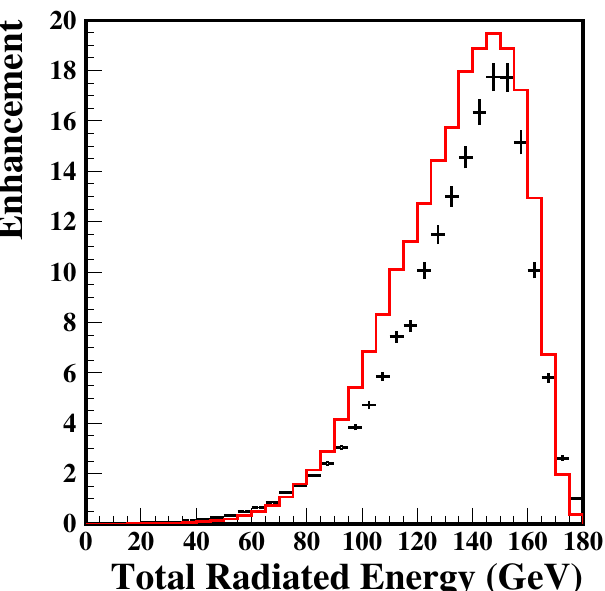
FIG. 25. Expected linear polarization as a function of the of the photons produced in the SOS-aligned Si crystal energy E (cid:1) in the tot by 178 GeV electrons.